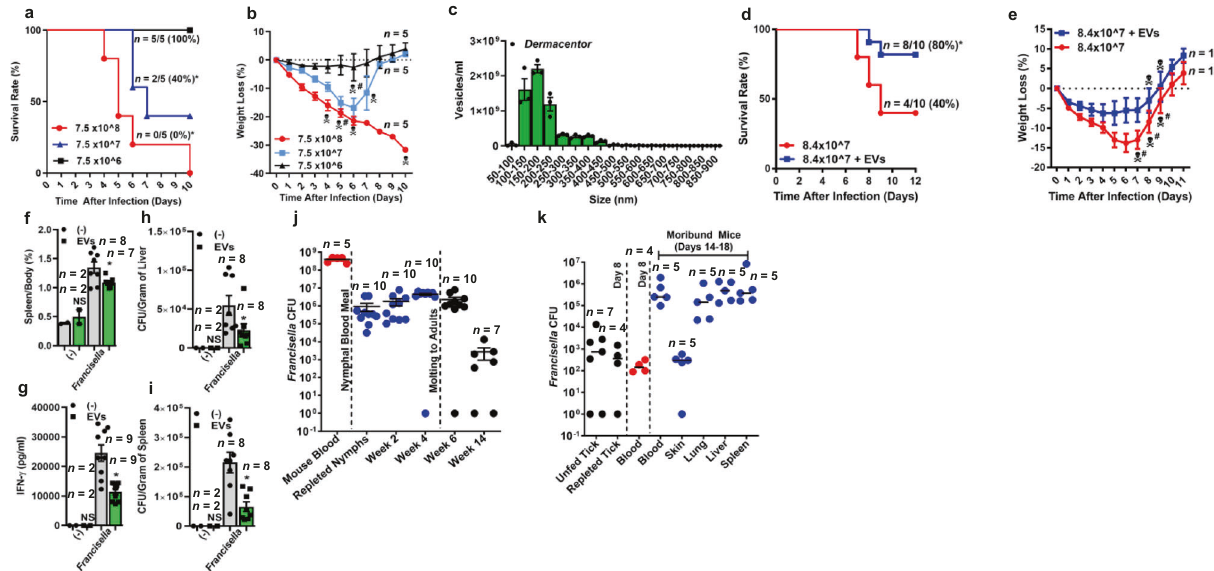
Fig. 6 D . andersoni EVs mitigate F. tularensis infection in the mammalian host. In a and b C57BL/6 mice were intradermally inoculated with three doses of F. tularensis live vaccine strain: 7.5 × 10 6 (black), 7.5× 10 7 (blue), and 7.5×10 8 (red). Survival and loss of weight were monitored daily for 10 days. Data represents the mean± SEM; n number of mice. c Quantity and size distribution of EVs puri fi ed from D. andersoni salivary glands, as judged by nanoparticle tracking analysis. Bars represent the standard error from three technical replicates. In d , e survival and weight loss in C57BL/6 mice inoculated with 8.4× 10 7 CFU of F. tularensis co-injected with 1 × 10 8 D. andersoni EVs. EV treatment (blue); control (red). For e , data presents the mean± SEM. In f – i F. tularensis (8× 10 7 CFU) was co-injected in the presence (green) or absence (gray) of D. andersoni salivary gland EVs (1× 10 8 ). f splenomegaly, g cytokine